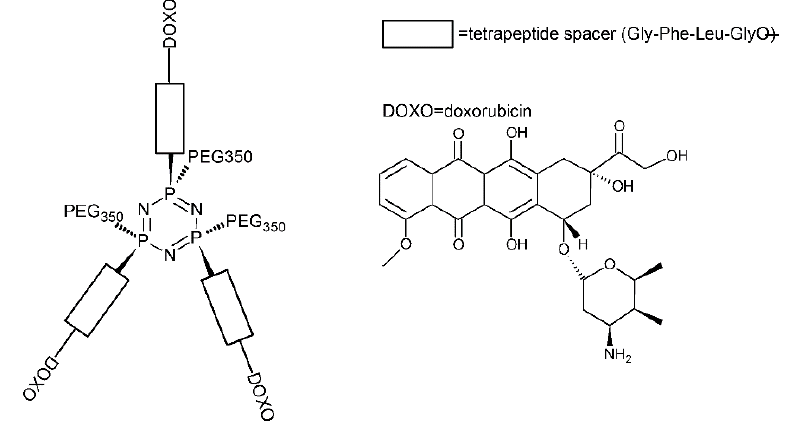
Figure 12. A biodegradable cyclophosphazene prodrug of doxorubicin.